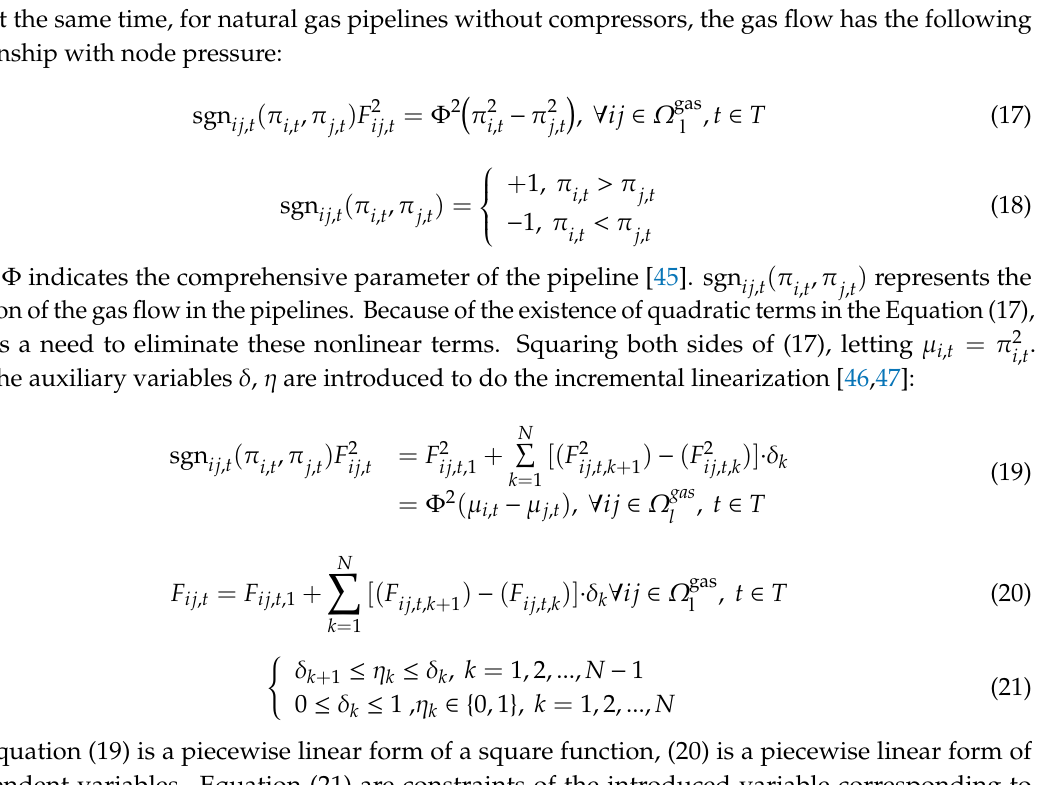
Figure 5. Natural gas pipeline